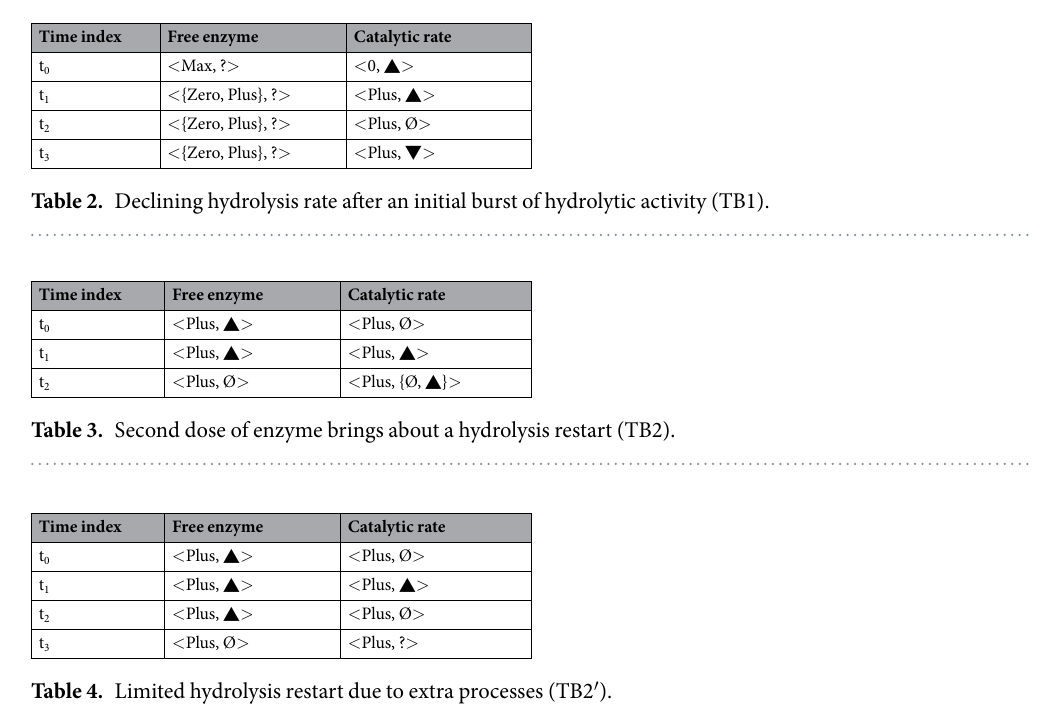
Figure 7. Hydrolysis of Avicel by cellulase cocktail from T. reesei . Left : Three hydrolysis curves of cellulose Avicel at 1% with 10 mg/g enzymes: without addition of fresh enzyme (REF), with addition of 10 mg/g enzymes at 1 h (Res1), and addition at 24 h (Res24) (arrows indicate the additions). Right : The corresponding instantaneous rates showing an exponential decrease over time with a marked restart of hydrolysis for Res1. Dash lines represent arbitrary fits to guide the eye on REF data-points. Error bars indicate standard errors.